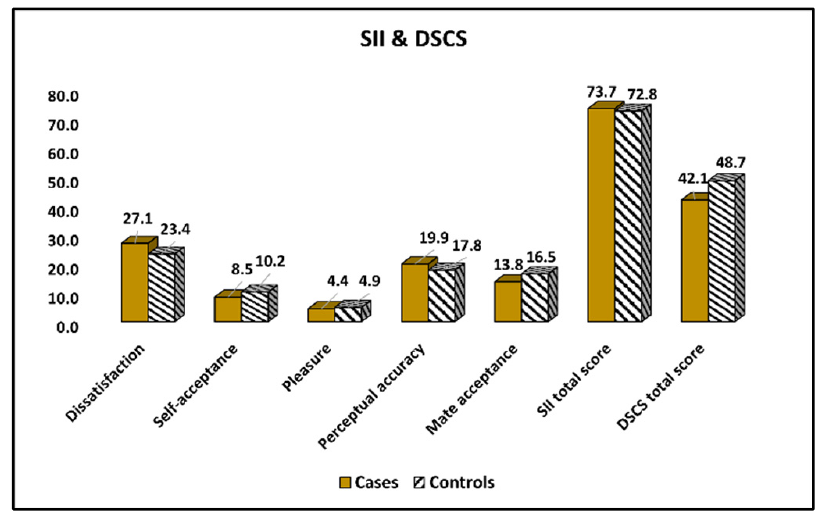
Figure 3. Comparison of SII survey results between cases and controls.